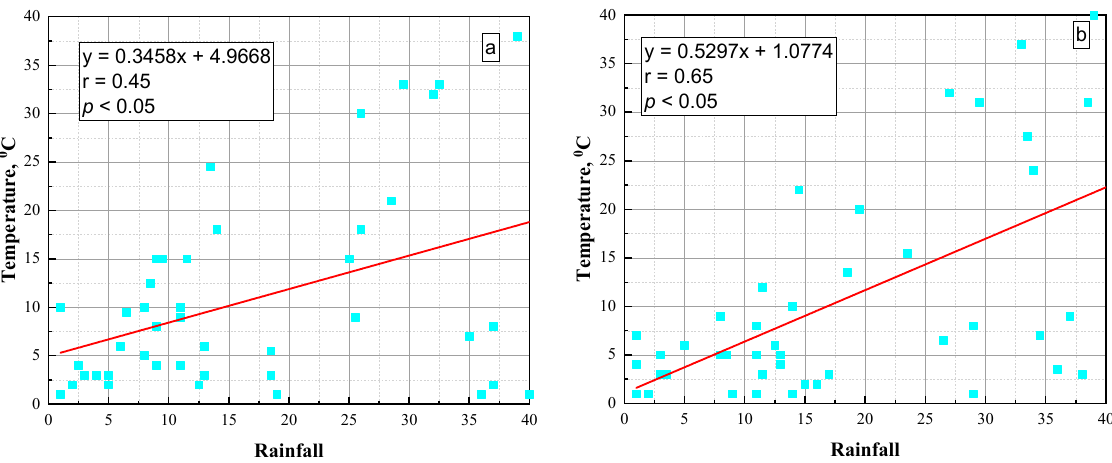
Figure 14. Spearman rank correlation coefficient for the air temperature and the rainfall average annual data: ( a )—the Novoselenginsk station, and ( b )—the Ulan-Ude station.